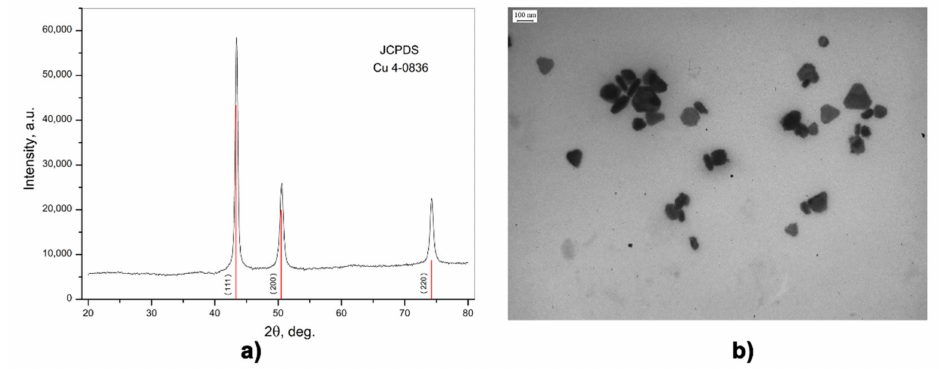
Figure 2. Di ff raction pattern ( a ) and TEM image ( b ) of Cu nanocrystals.